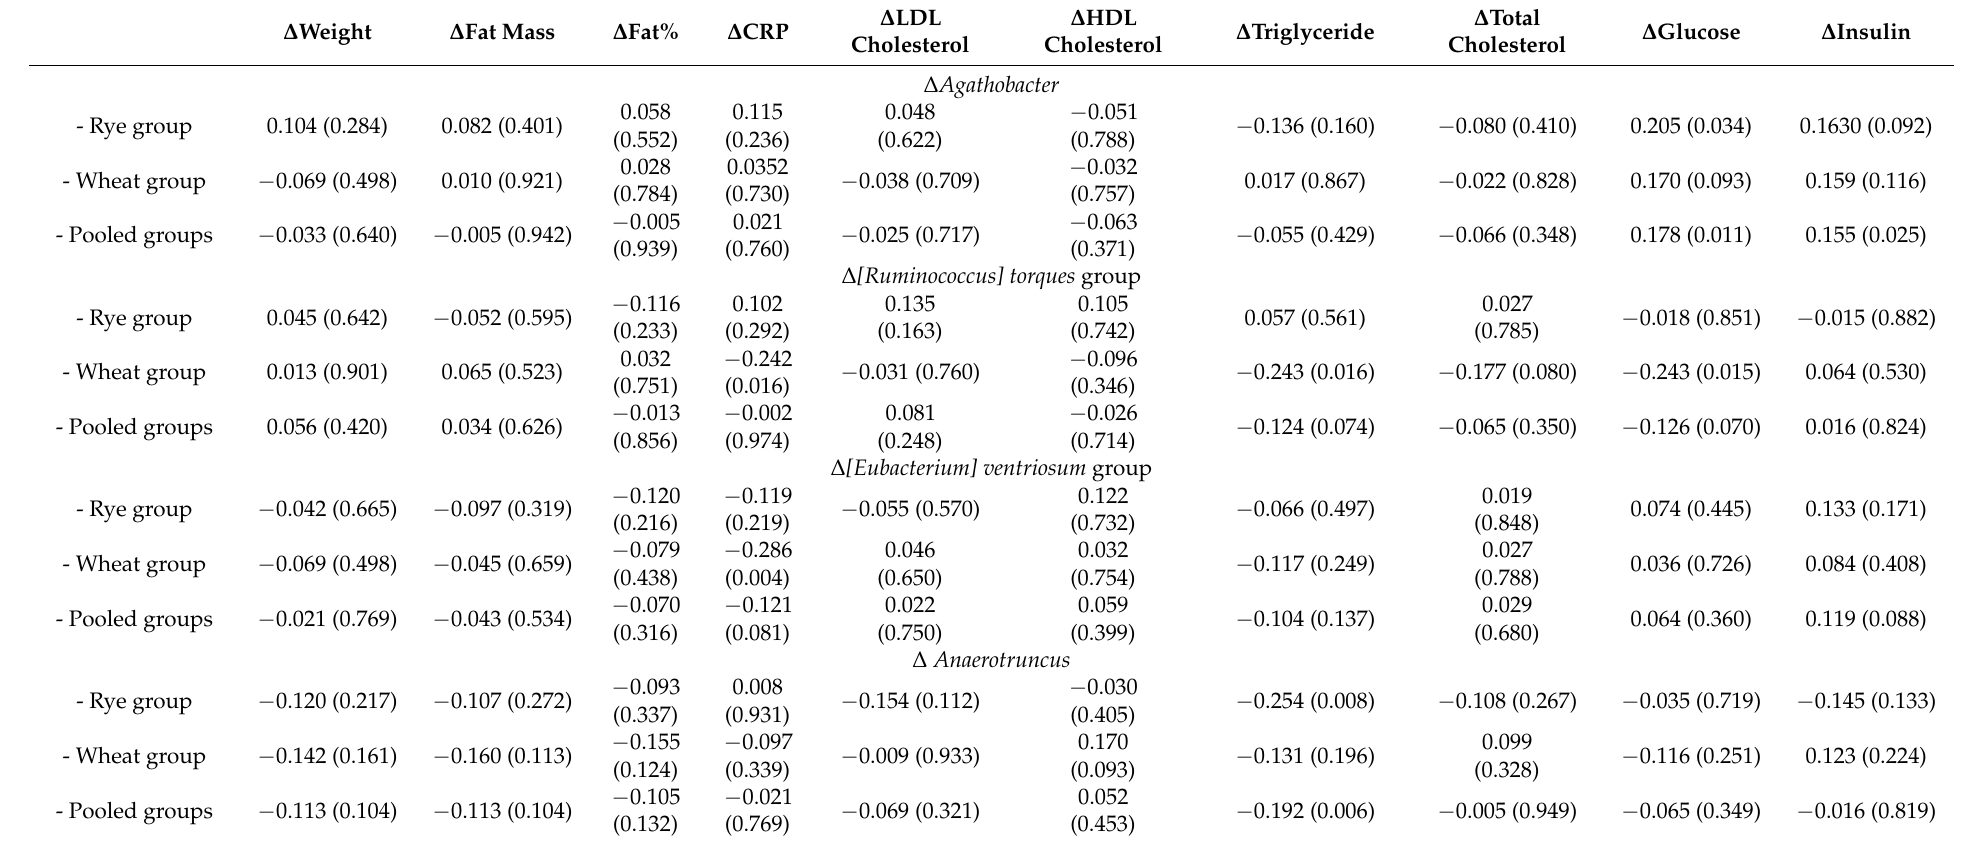
Table 3. Correlations between the change in relative abundance of the eight bacteria included in Table 2 and the changes in clinical outcomes over the 12-week intervention